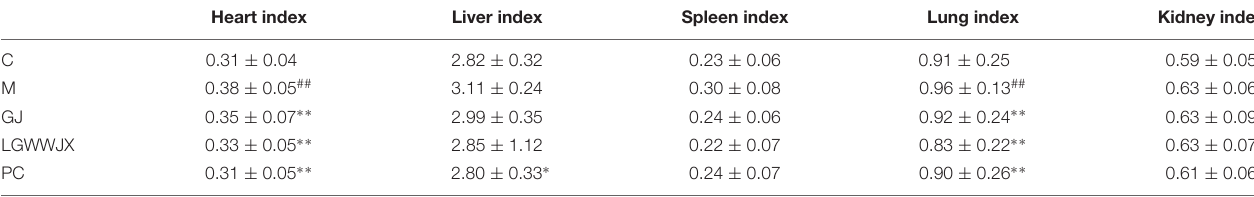
TABLE 2 | Visceral index results.